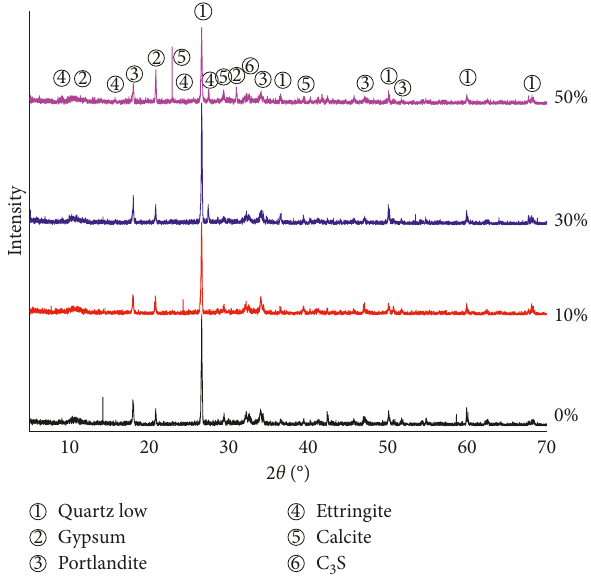
Figure 13: XRD patterns of mortars with different amounts at 3d age.